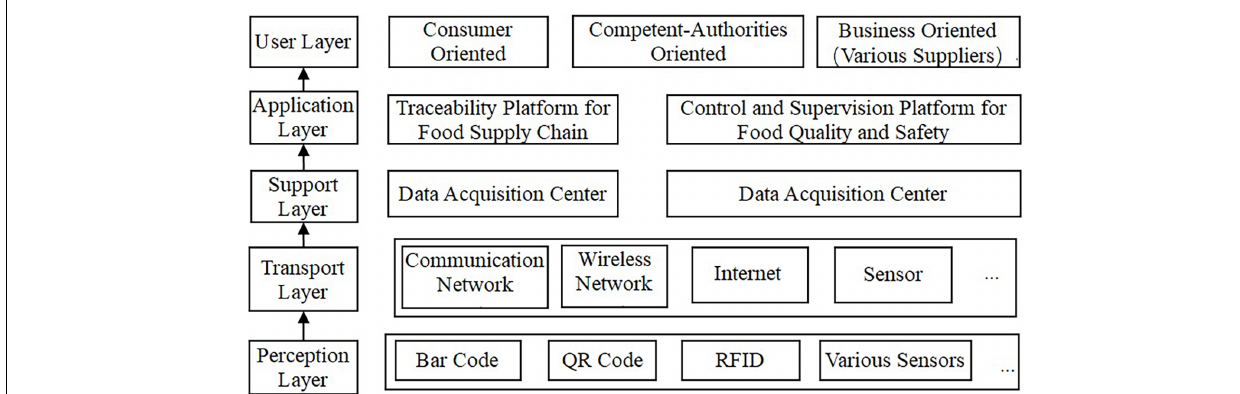
FIGURE 3 | The architecture of XRJ traceability system.